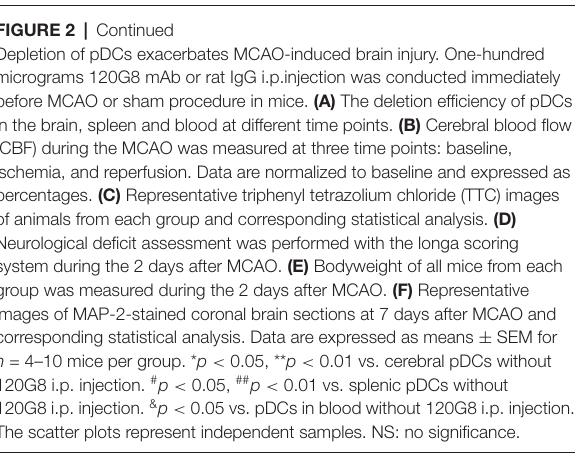
FIGURE 2 | Continued Depletion of pDCs exacerbates MCAO-induced brain injury. One-hundred micrograms 120G8 mAb or rat IgG i.p.injection was conducted immediately before MCAO or sham procedure in mice. (A) The deletion efficiency of pDCs in the brain, spleen and blood at different time points. (B) Cerebral blood flow (CBF) during the MCAO was measured at three time points: baseline, ischemia, and reperfusion. Data are normalized to baseline and expressed as percentages. (C) Representative triphenyl tetrazolium chloride (TTC) images of animals from each group and corresponding statistical analysis. (D) Neurological deficit assessment was performed with the longa scoring system during the 2 days after MCAO. (E) Bodyweight of all mice from each group was measured during the 2 days after MCAO. (F) Representative images of MAP-2-stained coronal brain sections at 7 days after MCAO and corresponding statistical analysis. Data are expressed as means ± SEM for n = 4–10 mice per group. * p < 0.05, ** p < 0.01 vs. cerebral pDCs without 120G8 i.p. injection. # p < 0.05, ## p < 0.01 vs. splenic pDCs